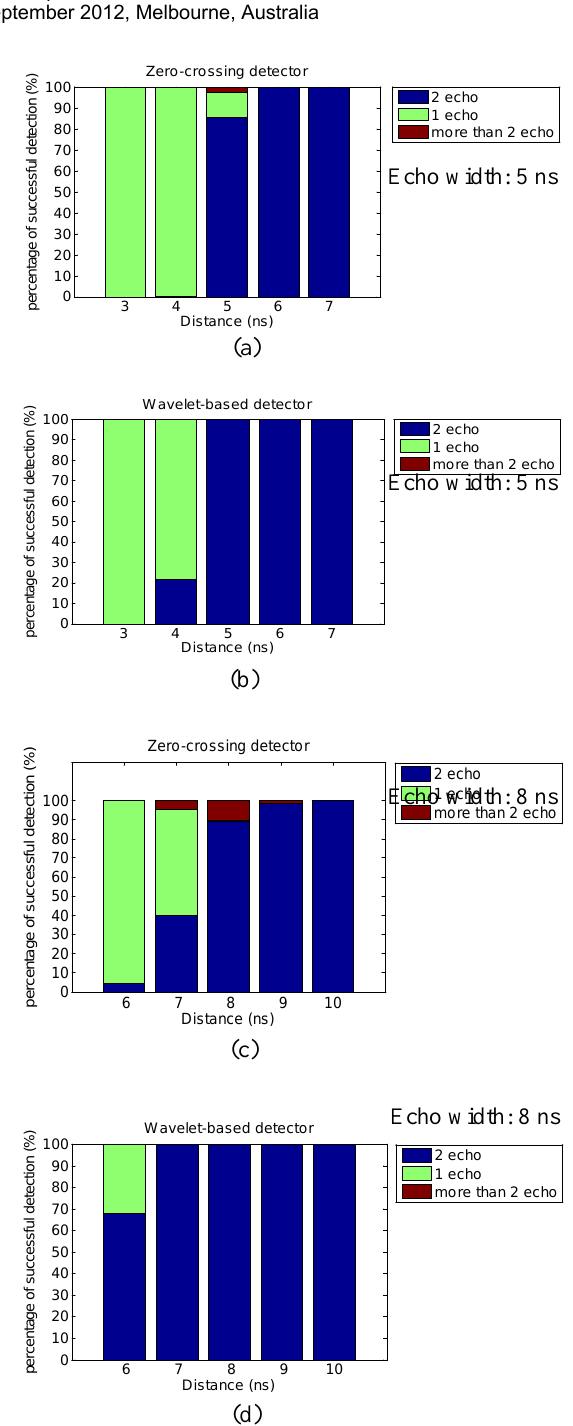
Figure 7. Results of overlapped echo detection with variant echo width and distance values, CR2: blue, MR2: green, RR2: red, (a)(c) zero-crossing, (b)(d)